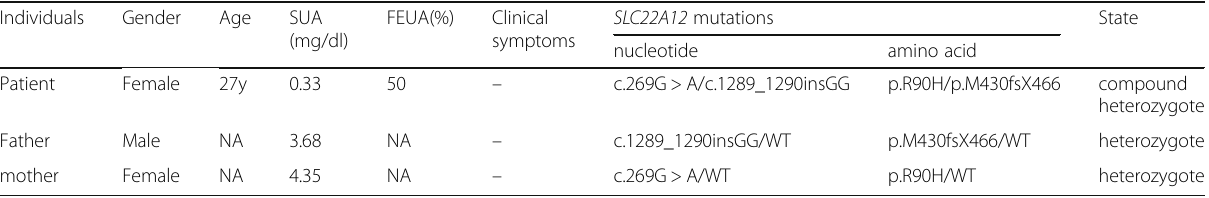
Table 1 Clinical data and confirmed SLC22A12 mutations in patient and both parents Individuals